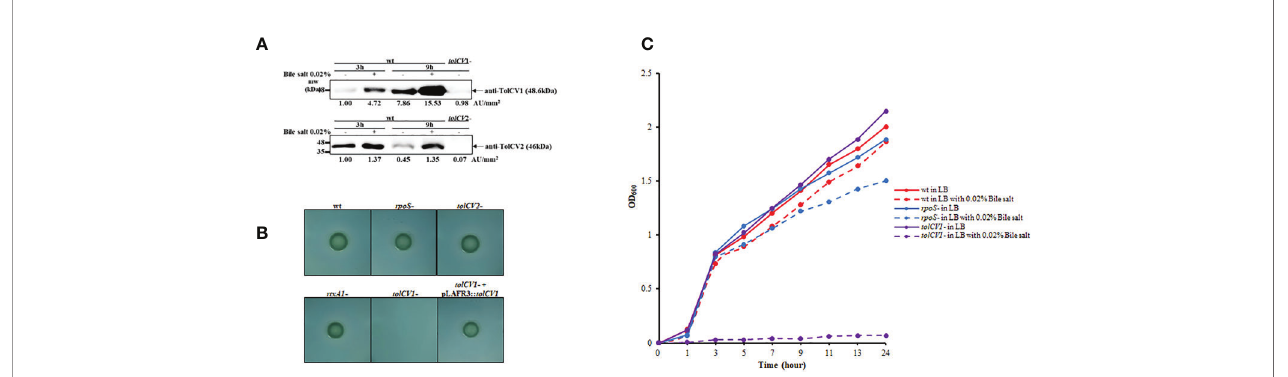
FIGURE 4 | Effect of tolCV1 or tolCV2 mutation on V. vulni fi cus resistance to bile salt. (A) V. vulni fi cus cells grown overnight in LB broth were diluted 200-fold with fresh LB medium containing 0.02% bile salt for 3 or 9 h. Equivalent number of bacterial cells (2×10 8 CFU) collected at 3 or 9 h cultures were subjected to Western blotting using anti-TolCV1 or anti-TolCV2 primary antibodies. Relative protein levels were quanti fi ed using ImageJ software. (B) Three microliters of overnight cultures of V. vulni fi cus strains were dropped on TCBS agar and then incubated overnight at 37°C. (C) Overnight cultures of V. vulni fi cus wild-type, rpoS mutant, or tolCV1 mutant strains were diluted 200-fold with fresh LB media in the presence or absence of 0.02% bile salt. Bacterial cells were cultured in a shaking incubator at 37°C and the growth was measured using a spectrophotometer at 600 nm every 2 h. Results are representative of at least three independent experiments. Abbreviation: wt, wild-type; tolCV1 -: tolCV1 mutant of MO6-24/O; tolCV1 - + pLAFR3:: tolCV1 : complementary strain of tolCV1 mutant; tolCV2 -: tolCV2 mutant of MO6-24/O; rpoS -: rpoS mutant of MO6-24/O; rtxA1 -: rtxA1 mutant of